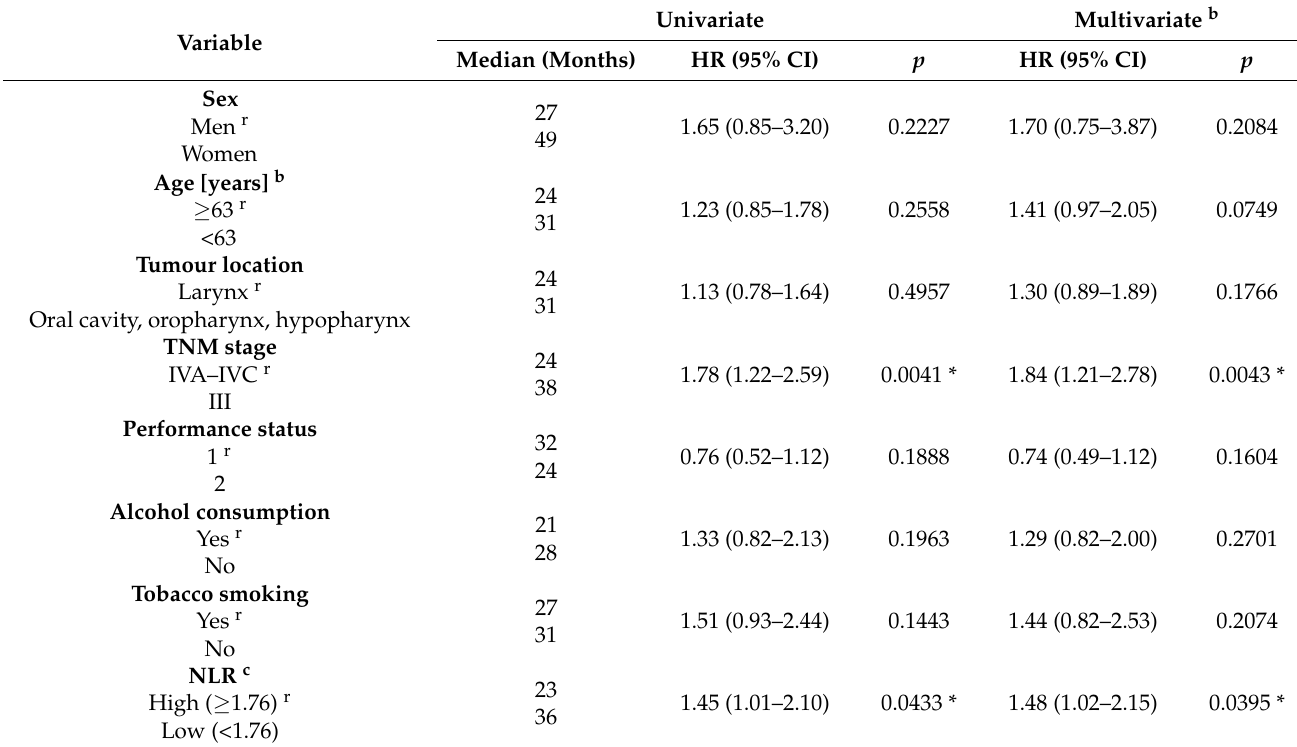
Figure 3. Kaplan–Meier curves illustrating death probability differences according to NLR values. Table 4. Overall survival analysis of HNC patients undergoing RT depending on demographic and clinical factors.